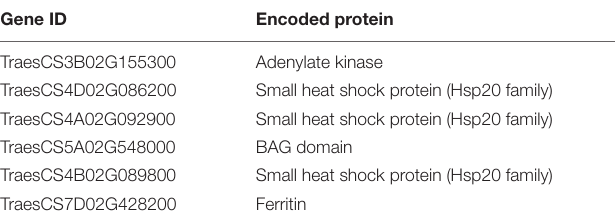
TABLE 1 | Upregulated genes common to all genotypes